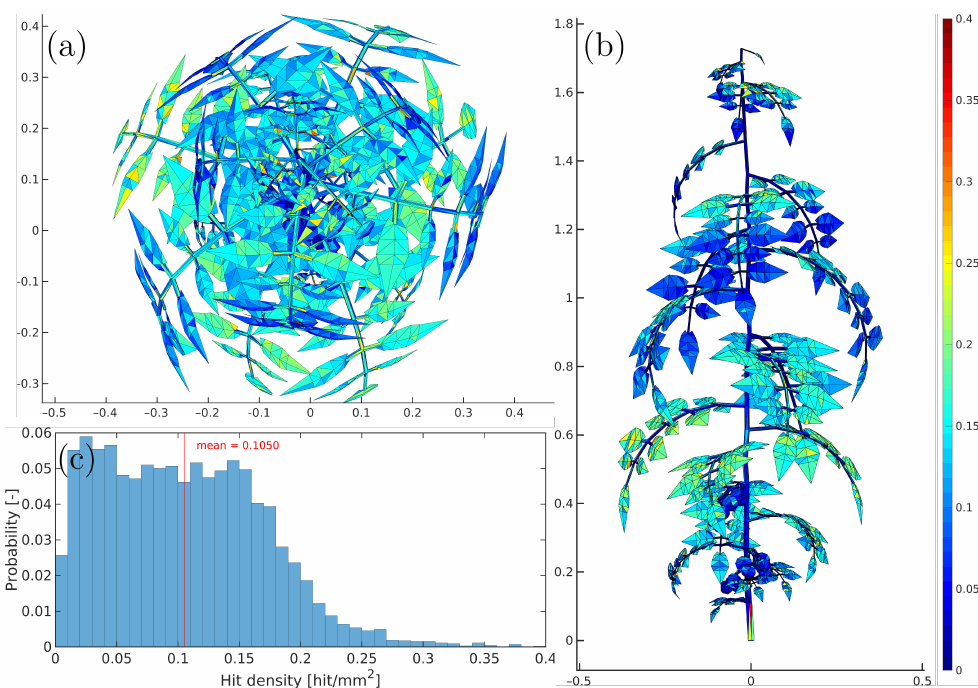
Figure 6. Visualization of the hit density (ray hits/mm 2 ) on the example of the full tomato model at zero perturbation in ( a ) top-, and ( b ) side-view, as well the the normalized histogram in sub-figure ( c ). Each triangle of the mesh model is coloured according to the number of rays that had hit is and the resulting hit